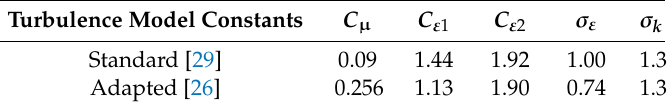
Table 1. Constants used in k − ε turbulence